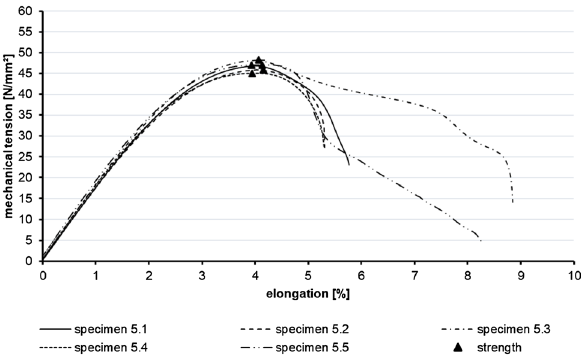
Fig. 15 Stress–strain diagram sample 2 (50% virgin material/50% recycled material)